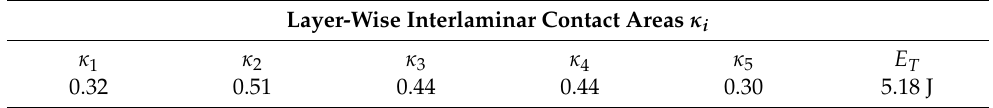
Table 4. Optimal interlaminar contact areas κ i for the layer-wise interface design.